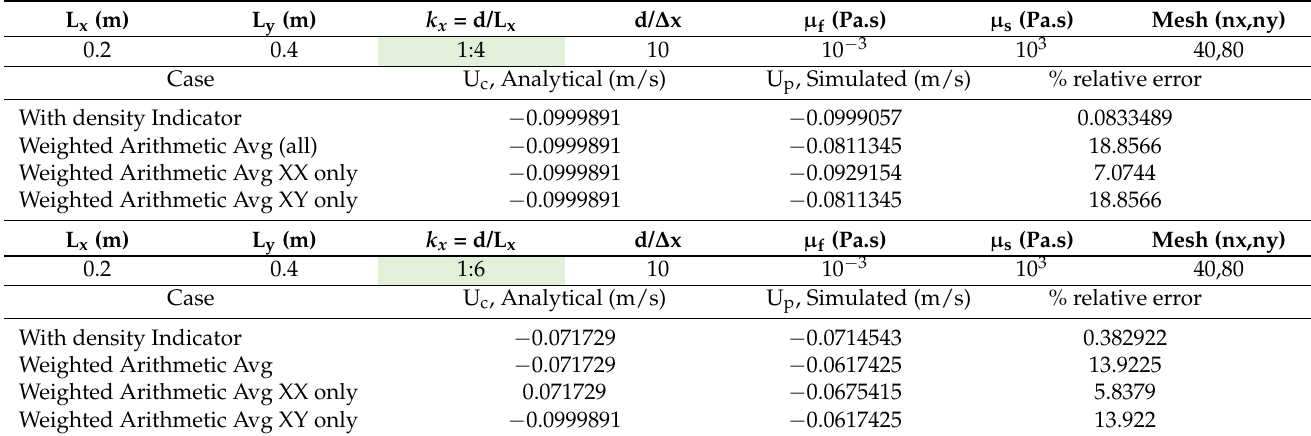
Table A3. Numerical Algorithm for interface cells.